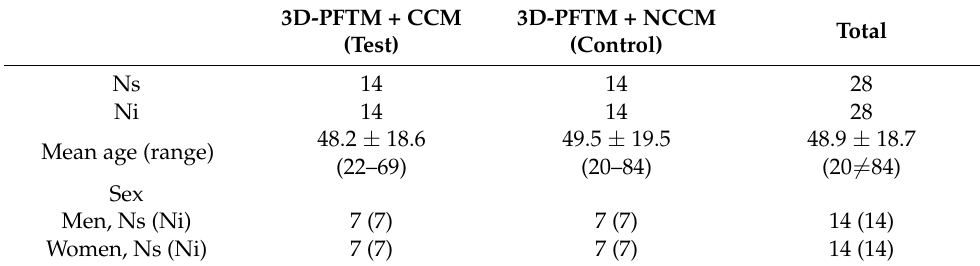
Table 1. Characteristics of